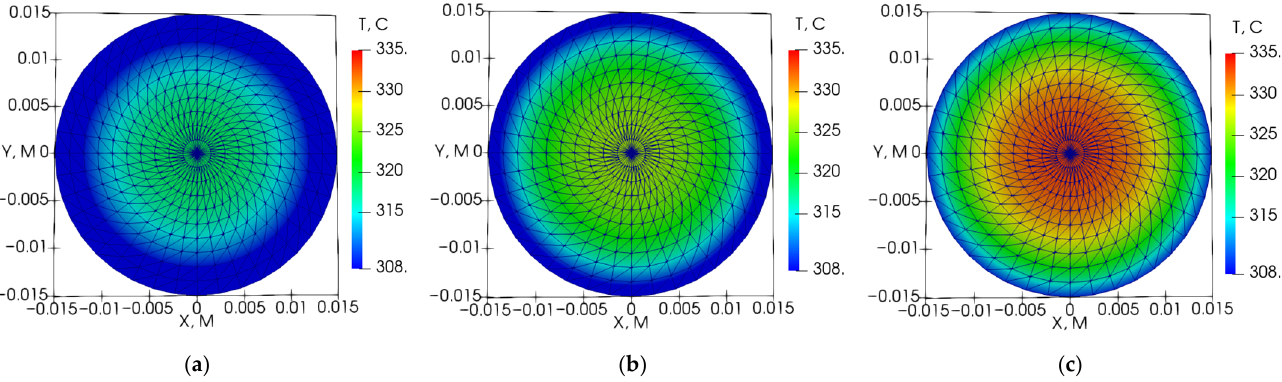
Figure 11. Temperature distribution in the middle section of the sample B2 under microwave exposure at different points in time: ( a ) 43 s; ( b ) 44 s; ( c ) 45 s.